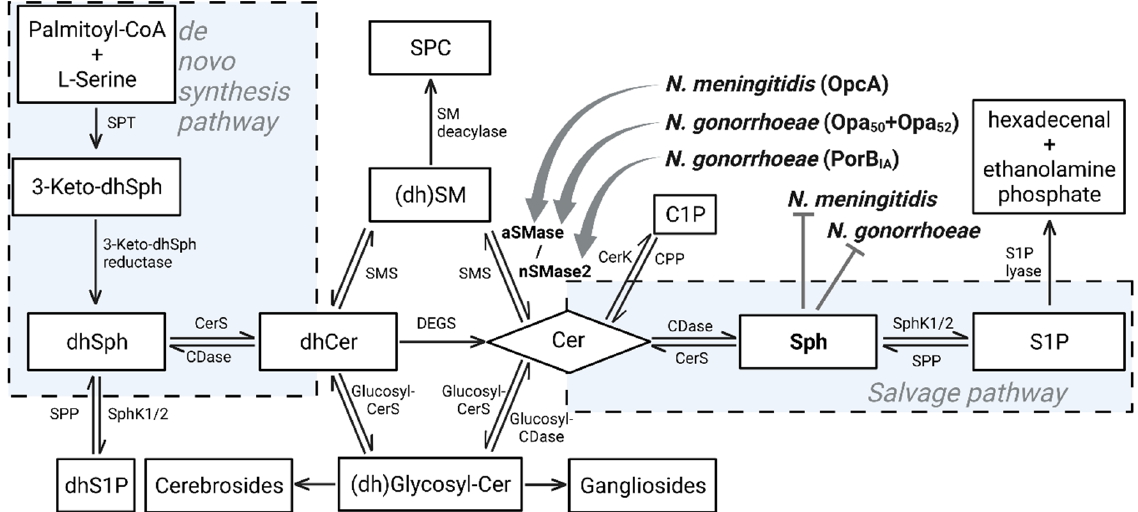
Figure 1. Schematic overview of the sphingolipid metabolic pathway. Both, N. meningitidis and N. gonorrhoeae are able to modulate sphingomyelinase (SMase) activity in host cells, either the acid SMase (aSMase) or neutral SMase 2 (nSMase2). Intriguingly, high sphingosine levels interfere with growth of intracellular gonococci or exhibit growth inhibitory effects on N. meningitidis under in vitro conditions. SPT: Serine palmitoyl transferase; (dh)Sph: (diydro)sphingosine; CerS: Ceramide synthase; CDase: Ceramidase; dhCer: dihydroceramide; DEGS: dihydroceramide desaturase; SMS: sphingomyelin synthase; (dh)SM: (dihydro)sphingomyelin; SPC: sphingosylphosphorylcholine; CerK: ceramide kinase; C1P: ceramide